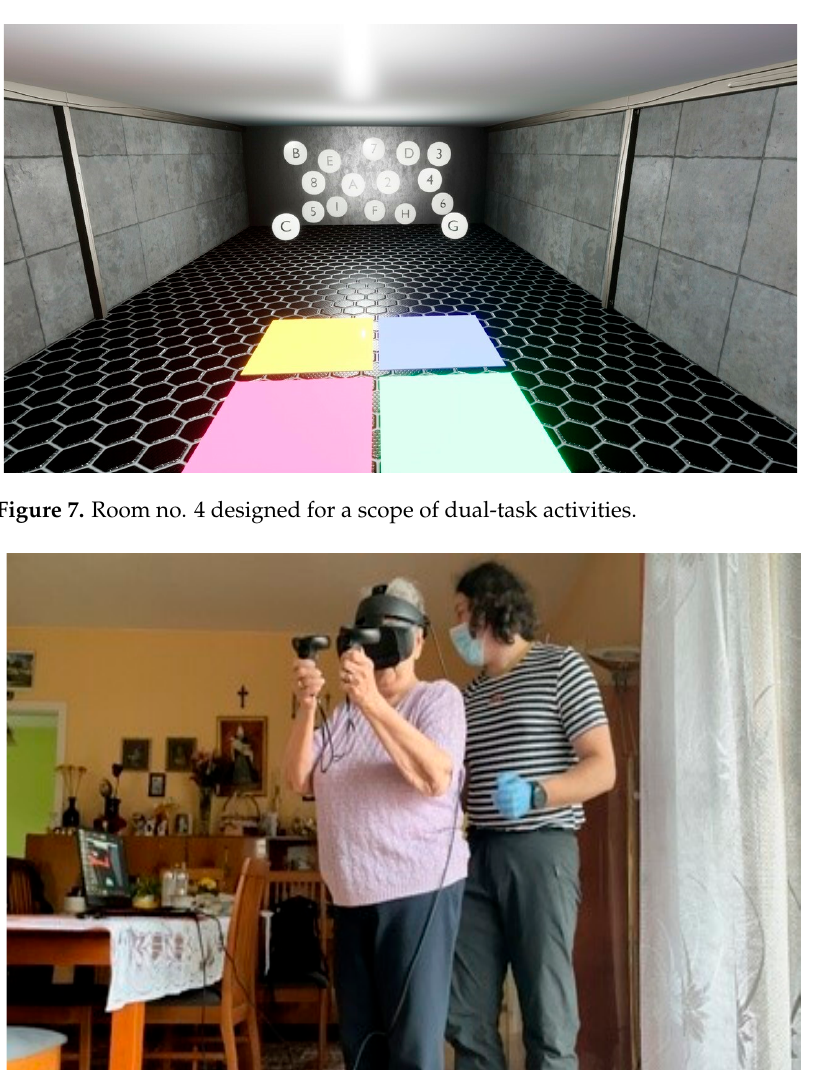
Figure 6. Room no. 3 designed for static and dynamic balance exercises.